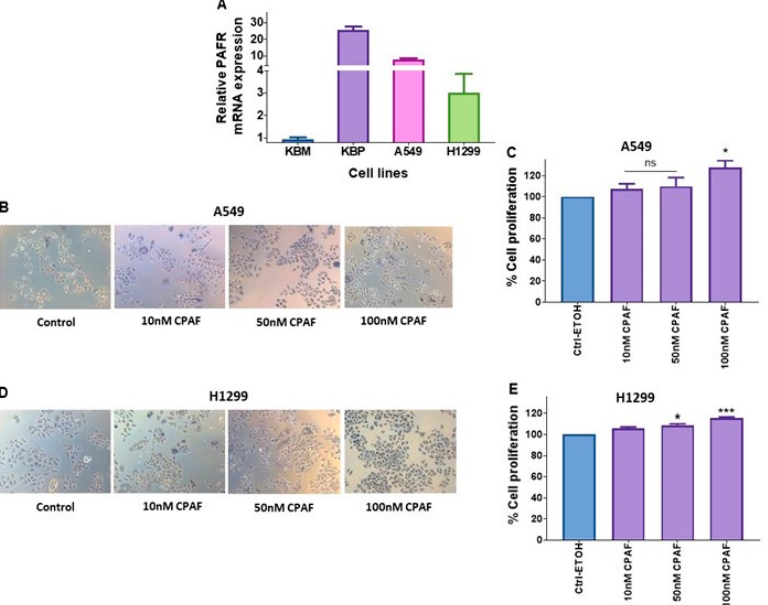
Figure 1. Evaluation of functional PAFR expression in human NSCLC cell lines. ( A ) The PAFR mRNA expression analysis in A549 and H1299 cell lines was undertaken via qPCR using KBP and KBM cells as positive and negative controls. ( B – E ) A549 and H1299 cell lines were treated with ve- hicle (0.1% ETOH) as control (Ctrl) or CPAF at given doses, and cultured for 48 h. The cell prolifer- ation was analyzed via MTT ( B , D ); the representative pictures are shown) and CV ( C , E ) assays. Data are expressed as the mean ± SE of three separate experiments. A statistically significant difference (* = p < 0.05; *** = p < 0.001) was observed by means of Student’s t -test between the control and 100 nM CPAF-treated groups.